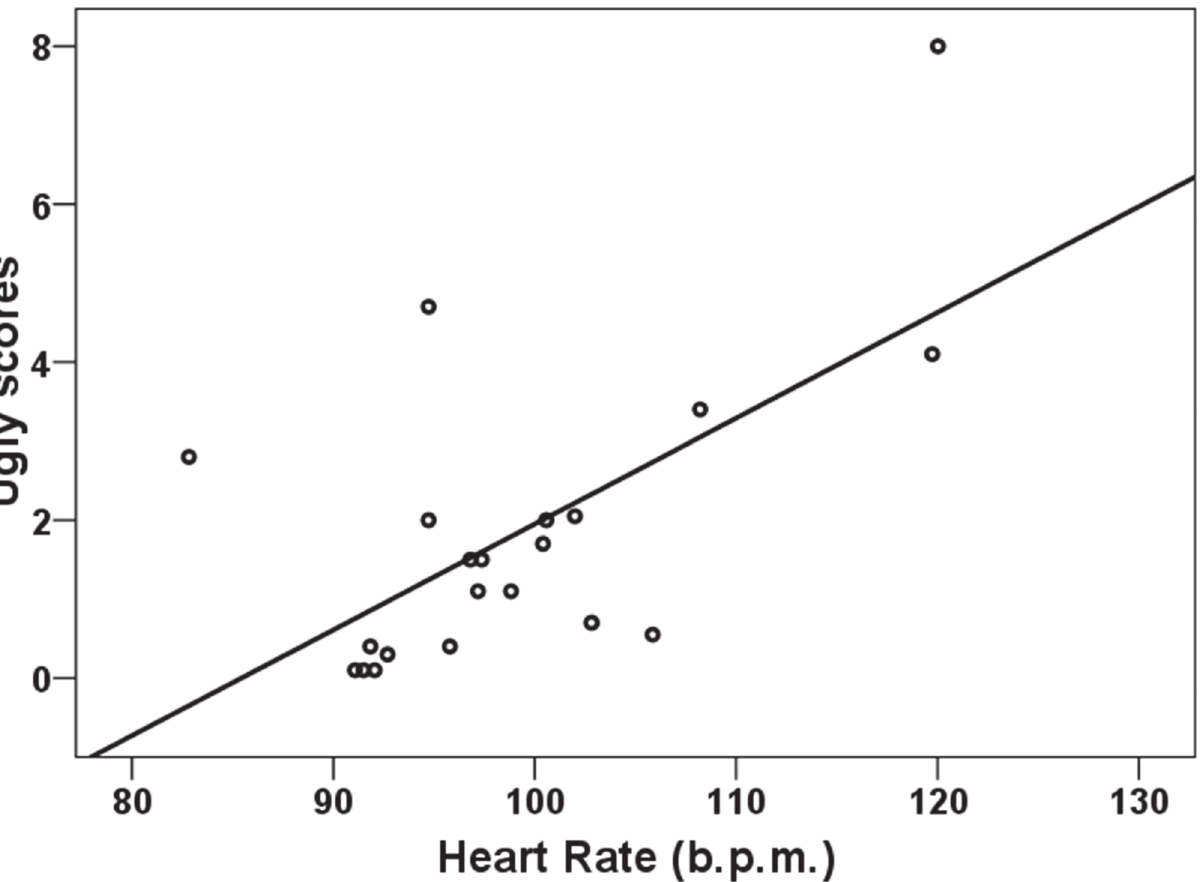
Fig 3. Ugly scores and heart rate (HR). Scatterplot and regression line for the relationship between ugly scores and averaged HR in the low body dissatisfaction group during exposition trial